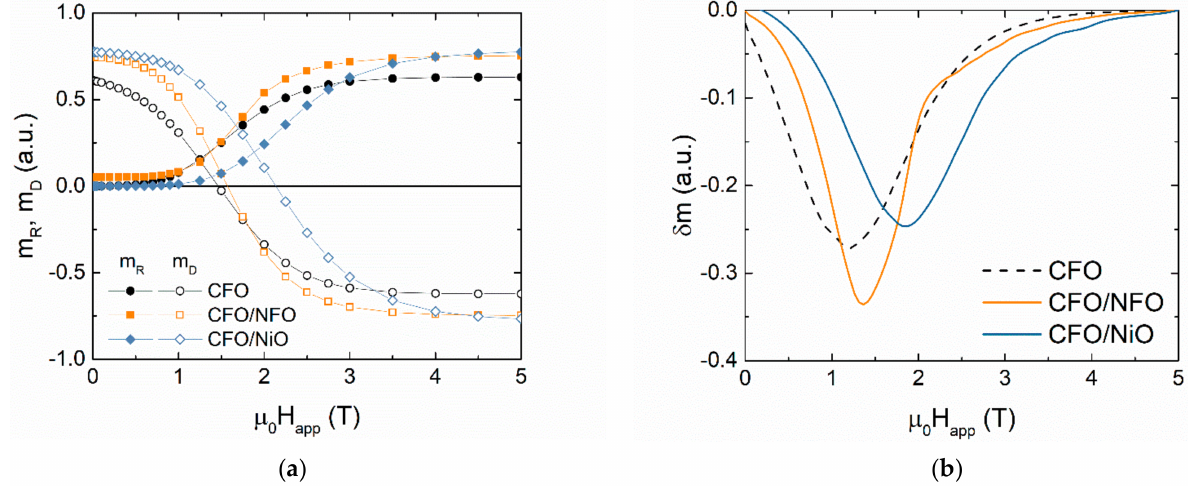
Figure 4. ( a ) m R and m D remanent magnetizations and ( b ) δ m-plots for CFO, CFO/NFO and CFO/NiO systems at 5